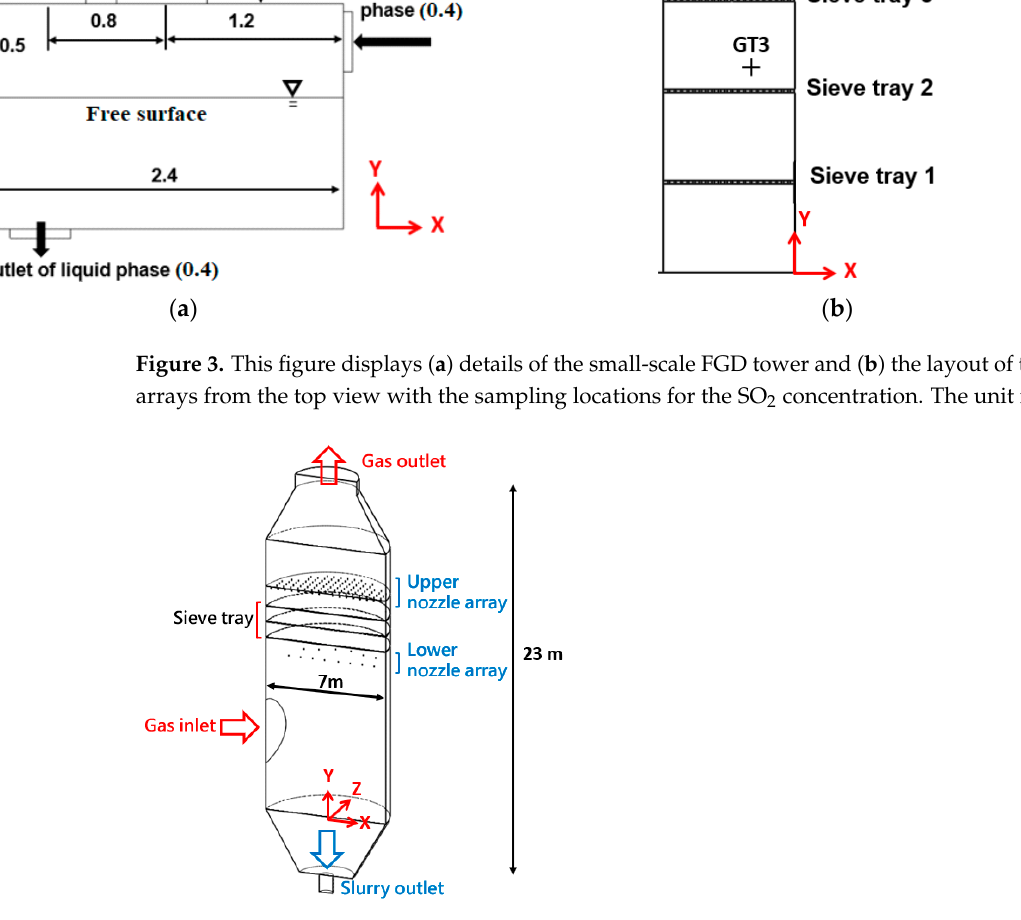
Figure 4. This figure highlights the details of the large-scale FGD tower. The unit is meter.